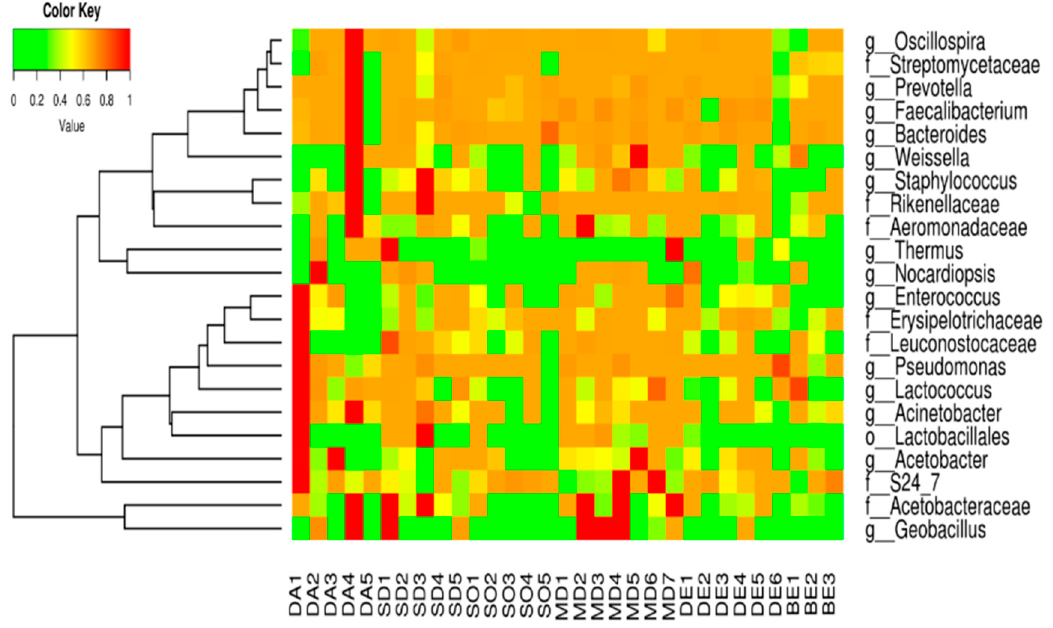
Figure 2. Relative abundances of more abundant bacterial taxa in the ready-to-eat dishes. The figure shows the food groups on the vertical axis and the horizontal axis shows the 20 most abundant bacterial genera in each group which are shared by at least 80% of the dish categories. The scale ranges from green (the least abundant) to yellow (the genera with medium abundance) and red (the most abundant bacterial genera). DA, dairy product; SD, side dishes; SO, soups; MD, main dishes; DE, deserts; BE,